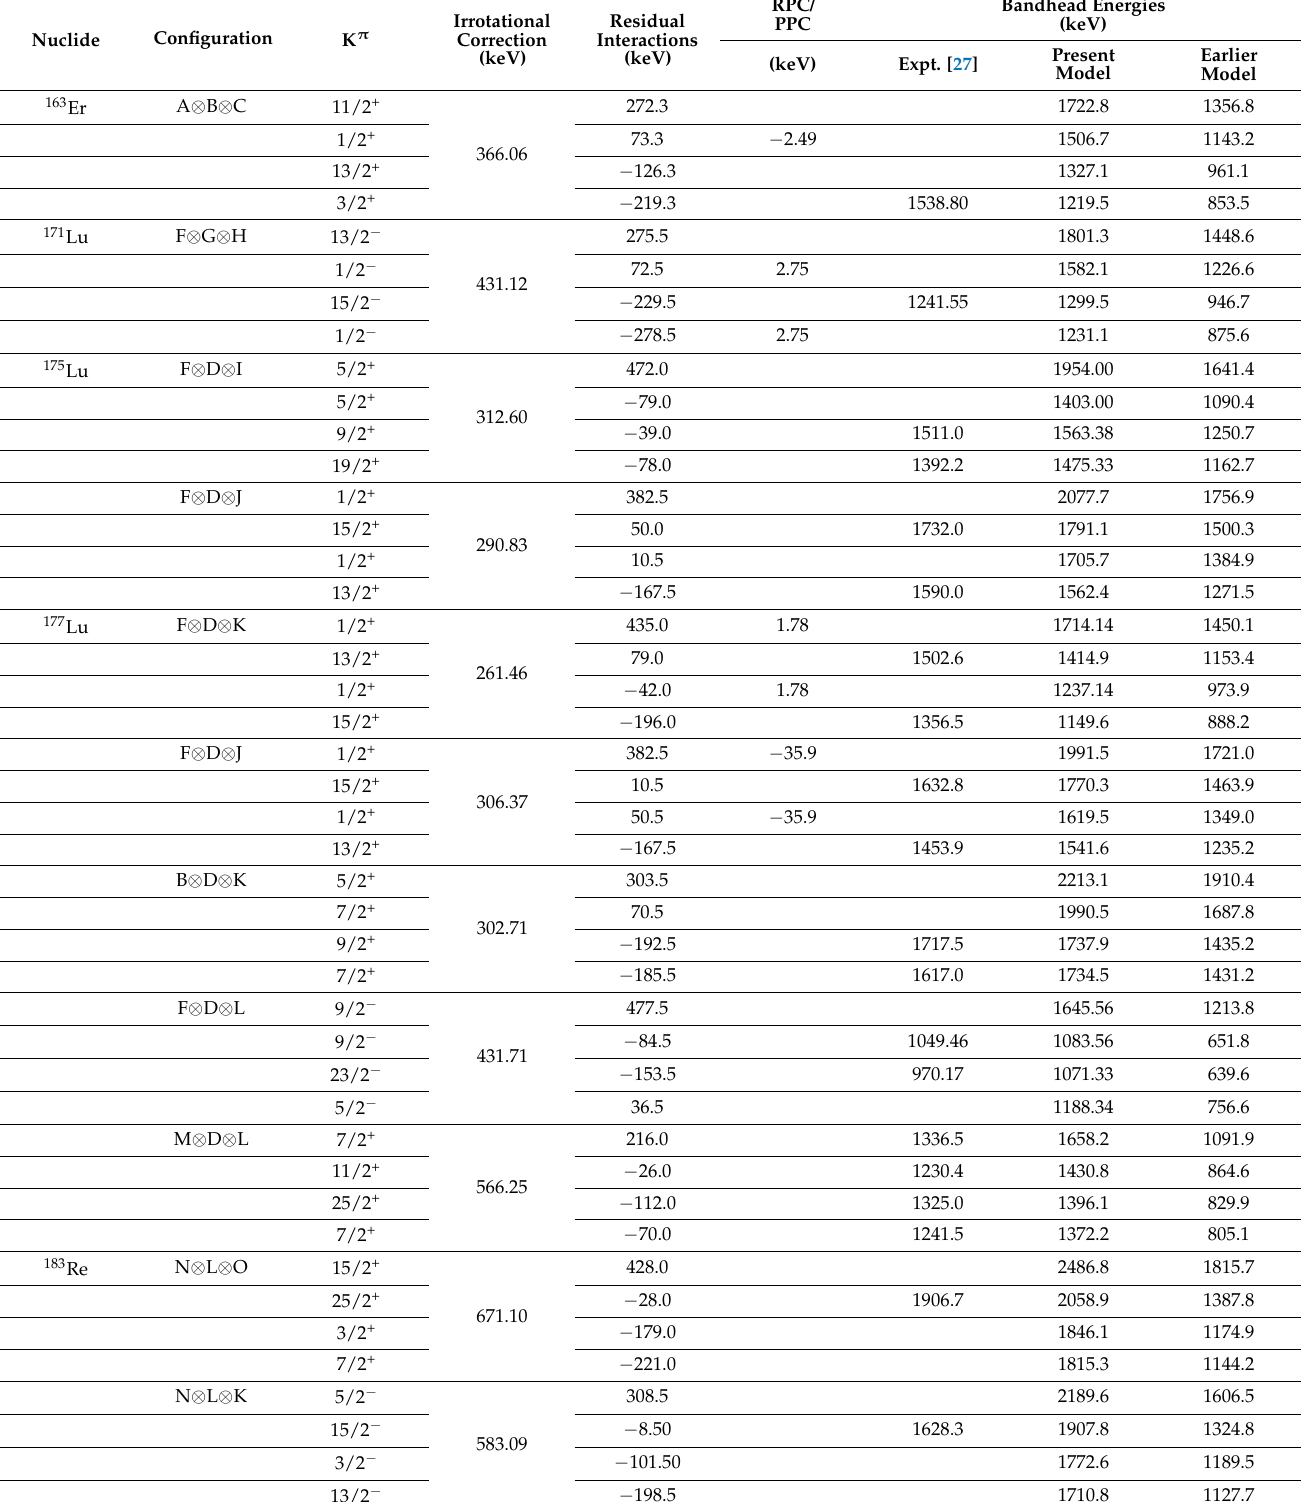
Table 3. GM splitting and Newby shift energies (in keV) extracted for proton–neutron, neutron– neutron and proton–proton 2qp configurations observed in neighboring even–even and odd–odd